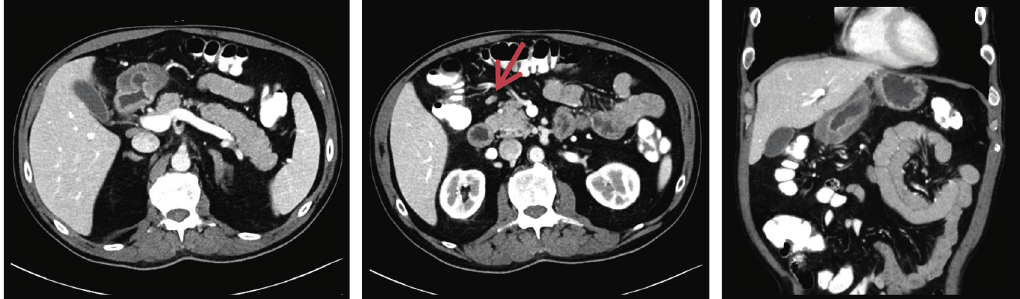
Figure 2: Computed tomography showing antral-wall thickening and mesenteric lymphadenopathy